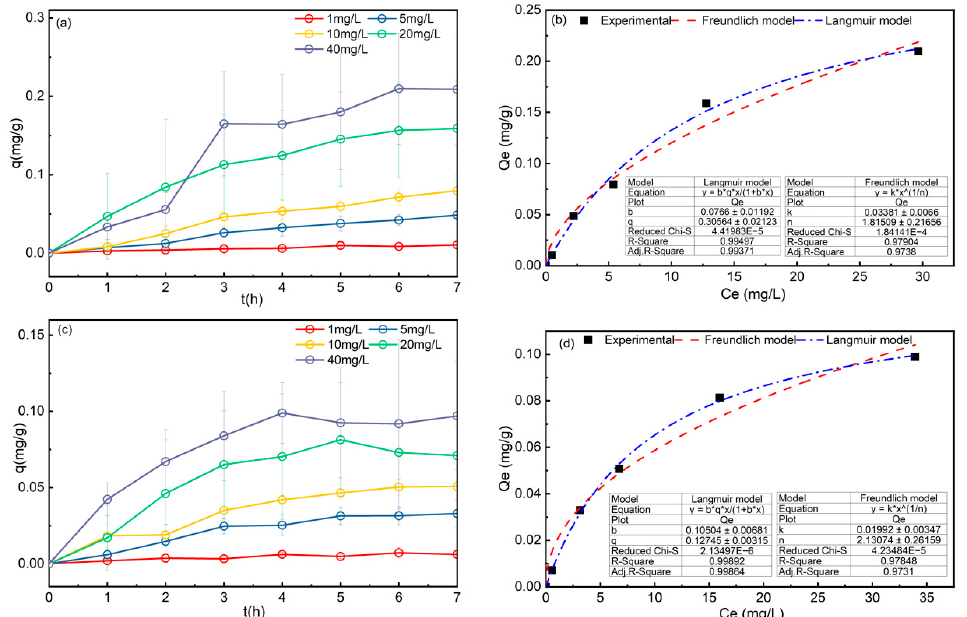
Figure 1. Static phosphate adsorption experiments of BFS. Shift of P equilibrium adsorption amount with the different initial concentrations of P. ( a ) BFS1 and ( c ) BFS2 and the corresponding adsorption isotherms fitted with Langmuir and Freundlich models. ( b ) BFS1; ( d ) BFS2.